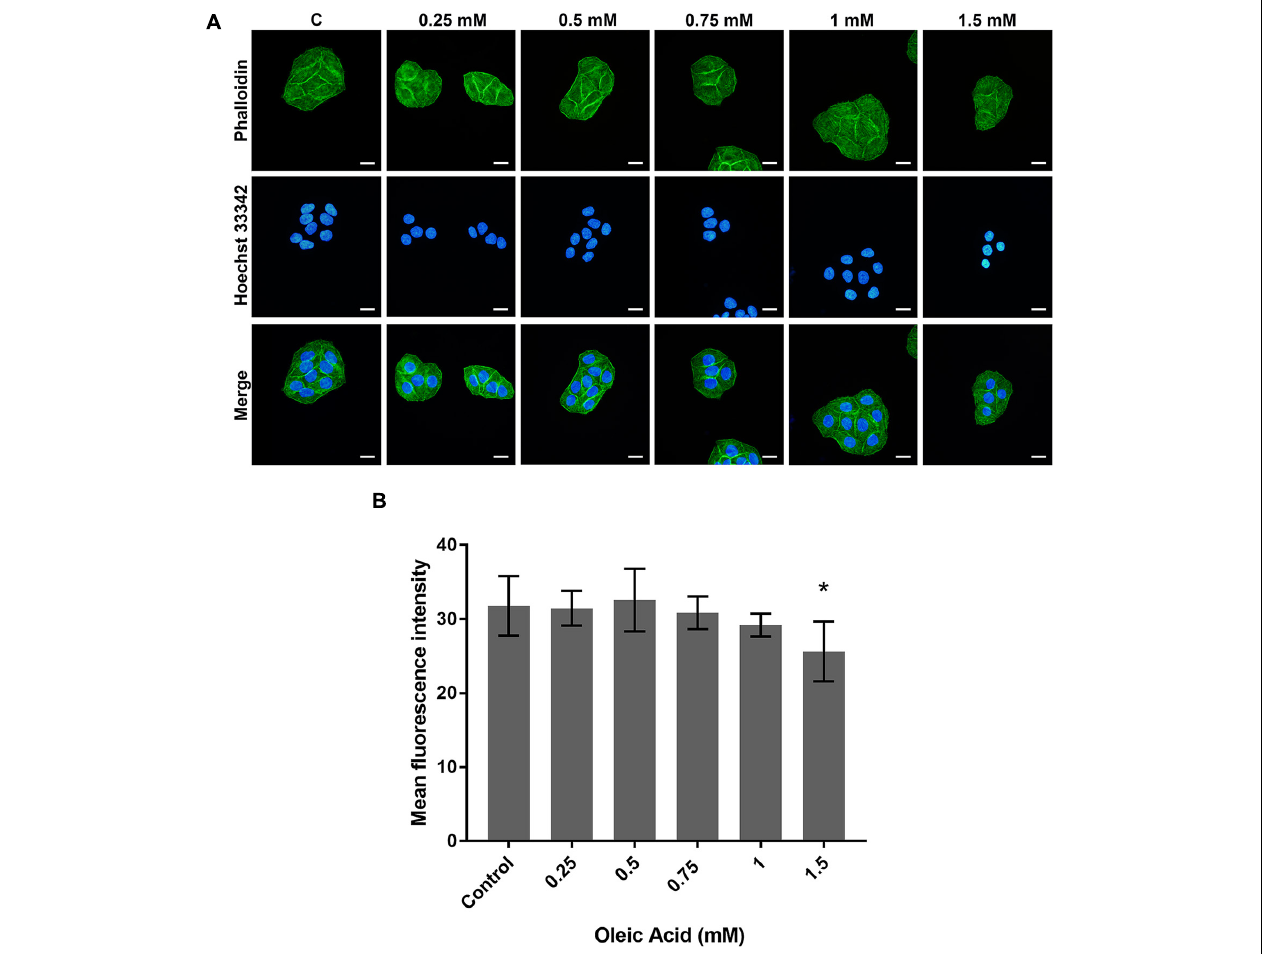
FIGURE 4 | Effects of OA on actin cytoskeleton arrangement for 24 h. (A) FITC-labeled Phalloidin was used to stain F-actin. Hoechst 33342 was used to stain nuclei. Images taken at 40 × magnification. Scale bars: 20 µ m. (B) The mean fluorescence intensity of F-actin. Experiments were performed in triplicates in three independent experiments. * p < 0.05, compared with the control